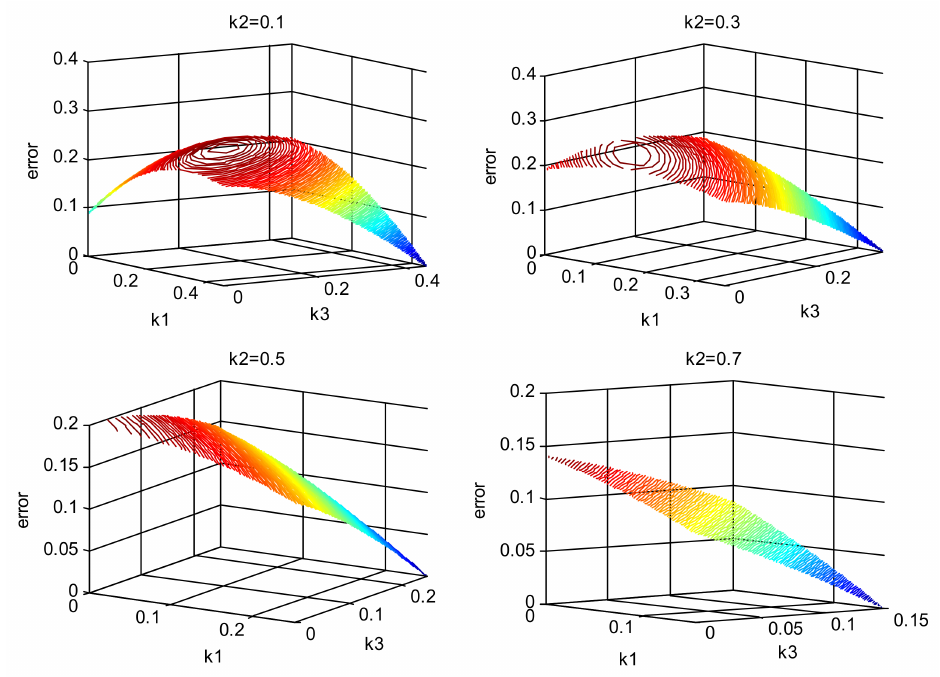
Figure 9. E ff ects of k 1 and k 3 on the system ISE value for di ff erent k 2 values.